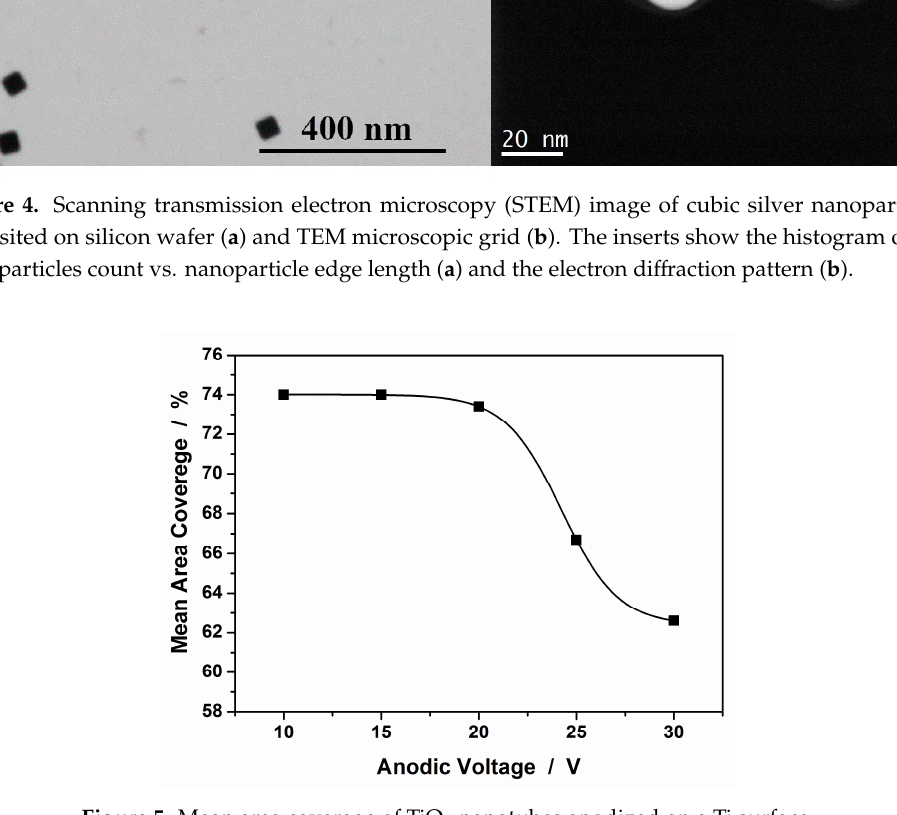
Figure 5. Mean area coverage of TiO 2 nanotubes anodized on a Ti surface.